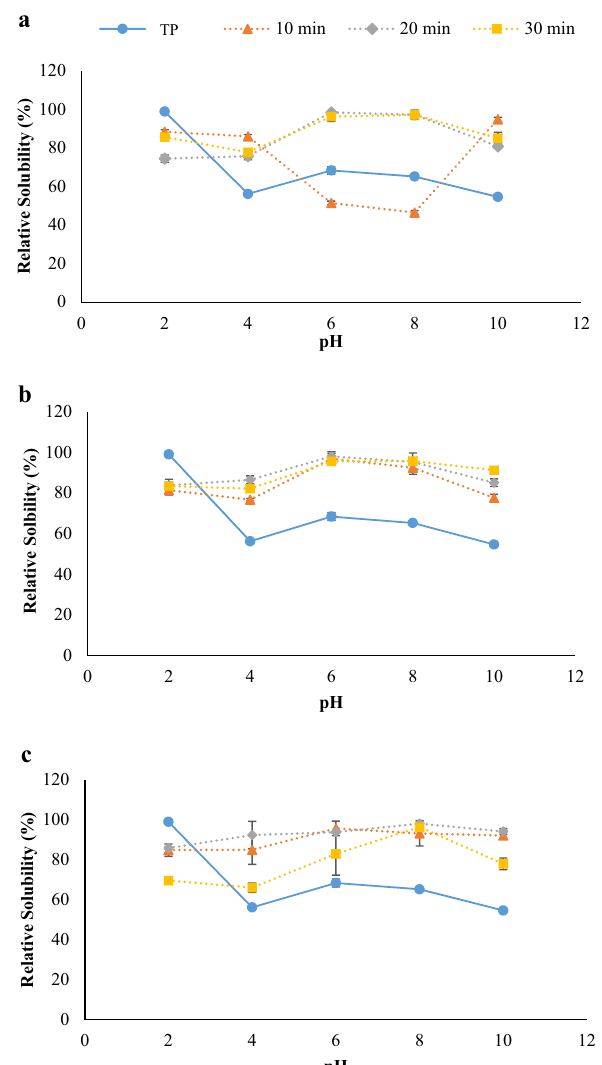
Figure 1. Relative solubility of protein extracted from Bombay locust by ultrasound-assisted process using 40% ( a ), 50% ( b ) and 60% ( c ) amplitudes at different ultrasonication times (10, 20, 30 min) in comparison with those from typical extraction process (TP). Bars represent the standard deviation (n = 3). Data obtained were analyzed by using One-way